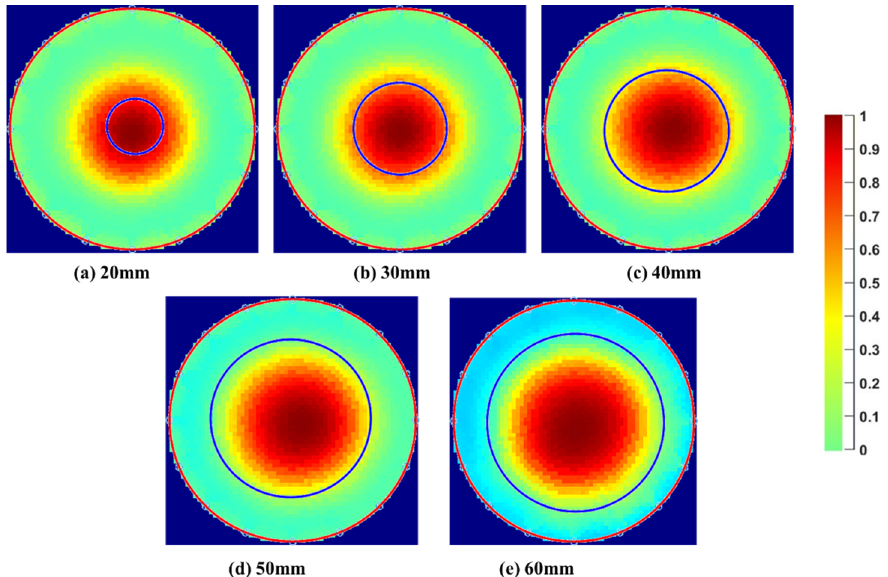
Figure 13. Diameter and position obtained using the proposed algorithm (blue) superimposed on the traditional tomograms in the low spatial resolution area. Case 20 mm to 60 mm phantom placed at the center of the sensing area. The colour bar is shown on the right side of the figure.